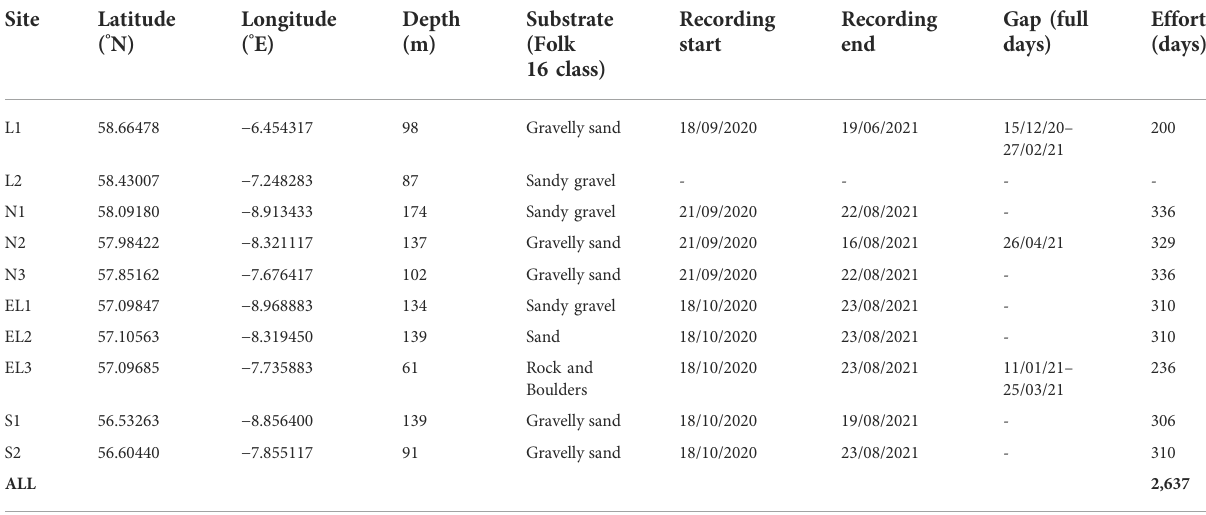
TABLE 1Deployment andeffort information forallacoustic moorings deployed during this study. Substrate data source:Seabed substrate 1:250,000 - Europe © EMODnet Geology, European Commission,